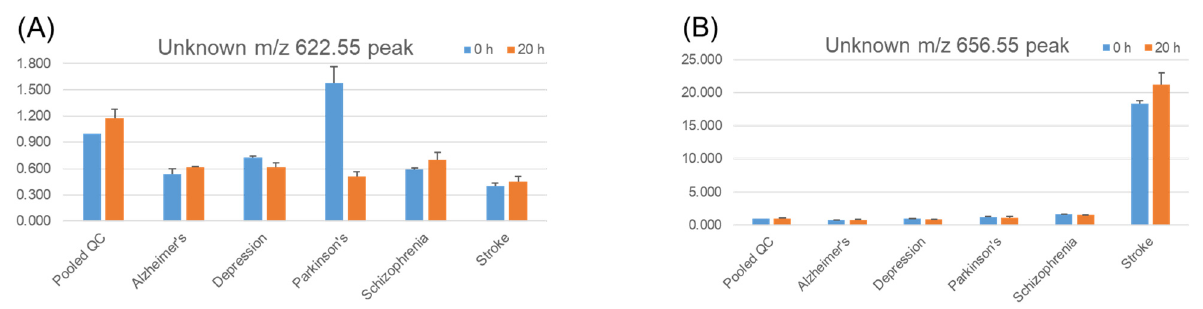
Figure 8. Stability of endogenous unknowns in serum. Pooled quality control (QC) serum samples and pooled disease serum samples were incubated at 37 °C for 20 h. Three replicates of each pooled serum sample were tested. Extraction, tandem mass tag (TMT) derivatization, and LC/MS analysis were performed as described in the Methods section. The Y -axis shows the values relative to those of pooled QC serum with no incubation (0 h) for each lipid. Error bars represent the standard error of the mean (SEM). ( A ) Unknown peak at m / z 622.55, ( B ) Unknown peak at m / z 656.55.